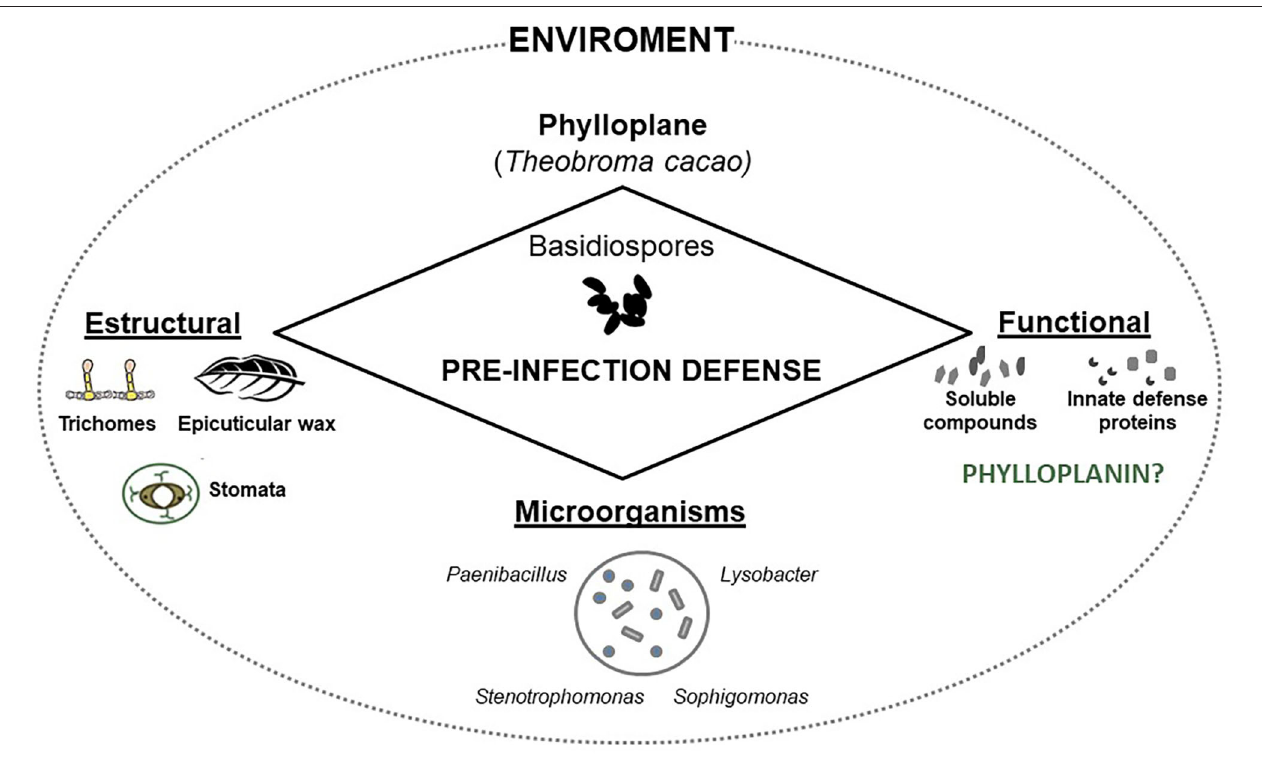
FIGURE 5 | Pre-infection defense of the Theobroma cacao phylloplane. Schematic interaction between cocoa phylloplane (chemical and structural mediators and microorganisms) and inhibition of Moniliophthora perniciosa basidiospores during adhesion, germination, and germ tube formation signaling